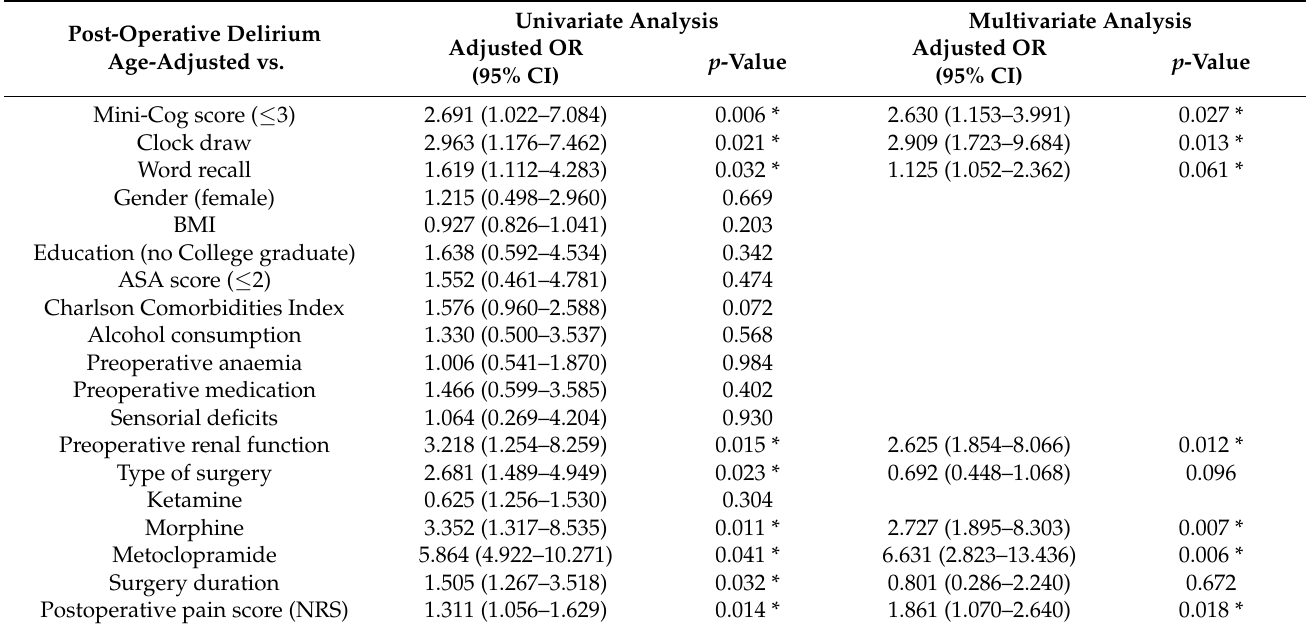
OR—odd ratio; CI—confidence interval; BMI—body mass index, ASA—American Society of Anaesthesiology, NRS—Numeric Rating Scale; (*) Marked effects are significant at p <